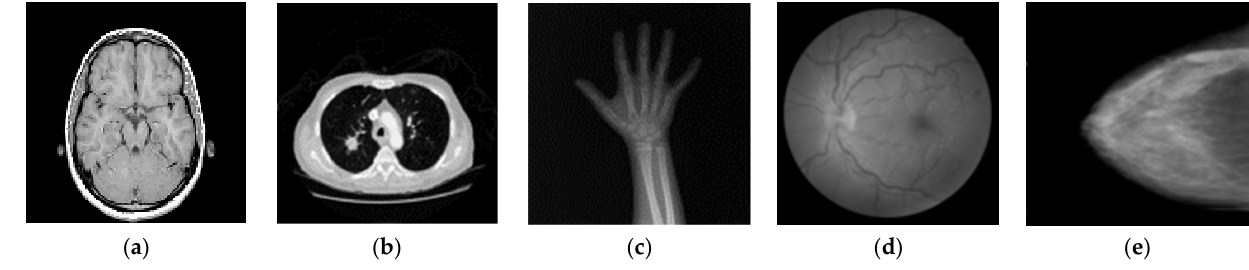
Figure 6. Original medical images: ( a ) brain; ( b ) chest; ( c ) hand; ( d ) fundus vessels; and ( e ) breast.